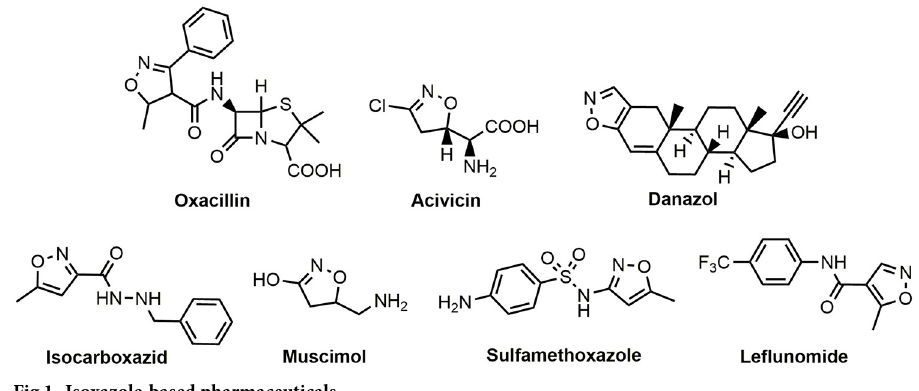
Fig 1. Isoxazole-based